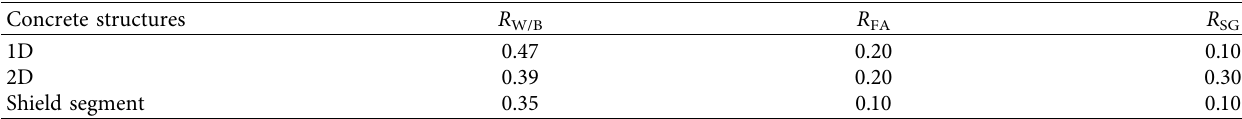
Concrete structures